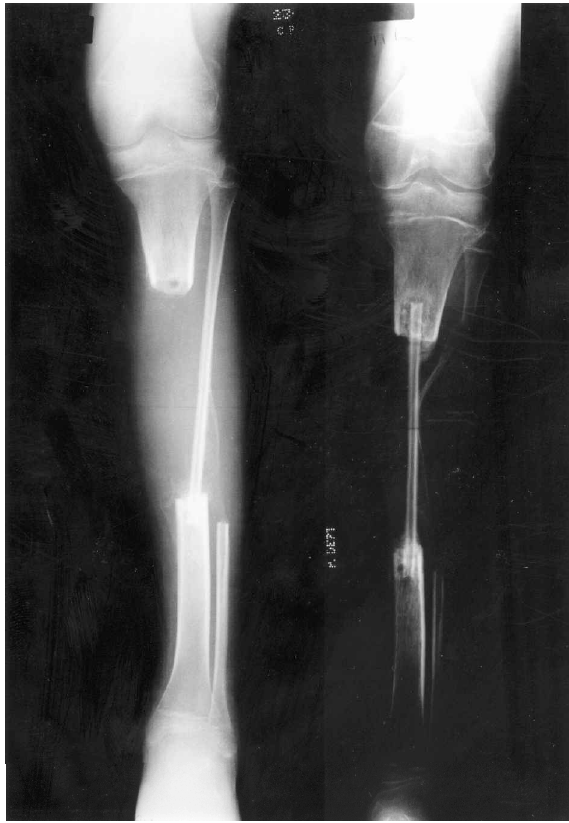
Fig. 1. Anteroposterior view of postoperative radiographs of 15-year-old boy who had a malignant ® brous histiocytoma in the mid-shaft left tibia. Left: Two months after the ® rst stage procedure showing 14 cm tibial bone defect following tumour resection, and the distal ® bular osteotomy and transfer into the canal of distal tibial segment. Right: One month after the second stage procedure showing the proximal ® bular osteotomy and transfer into the canal of proximal tibial segment.